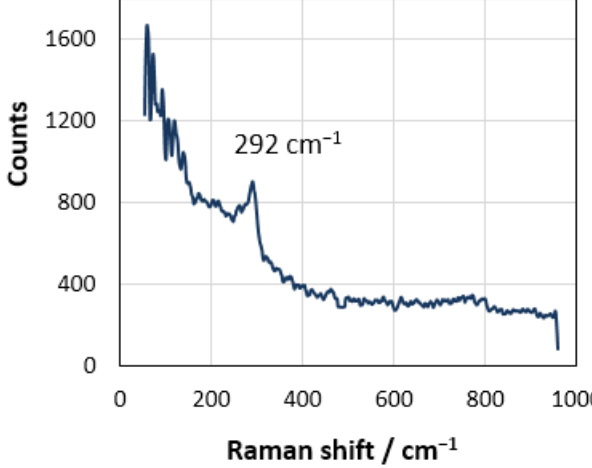
Figure 6. Raman spectra for the Re electrode surface after anodic polarization in the molten potassium chloride (Renishaw Raman microscope-spectrometer U 1000 equipped with a confocal Leica DML microscope, argon laser with a power density below 40 Wcm − 2 ).